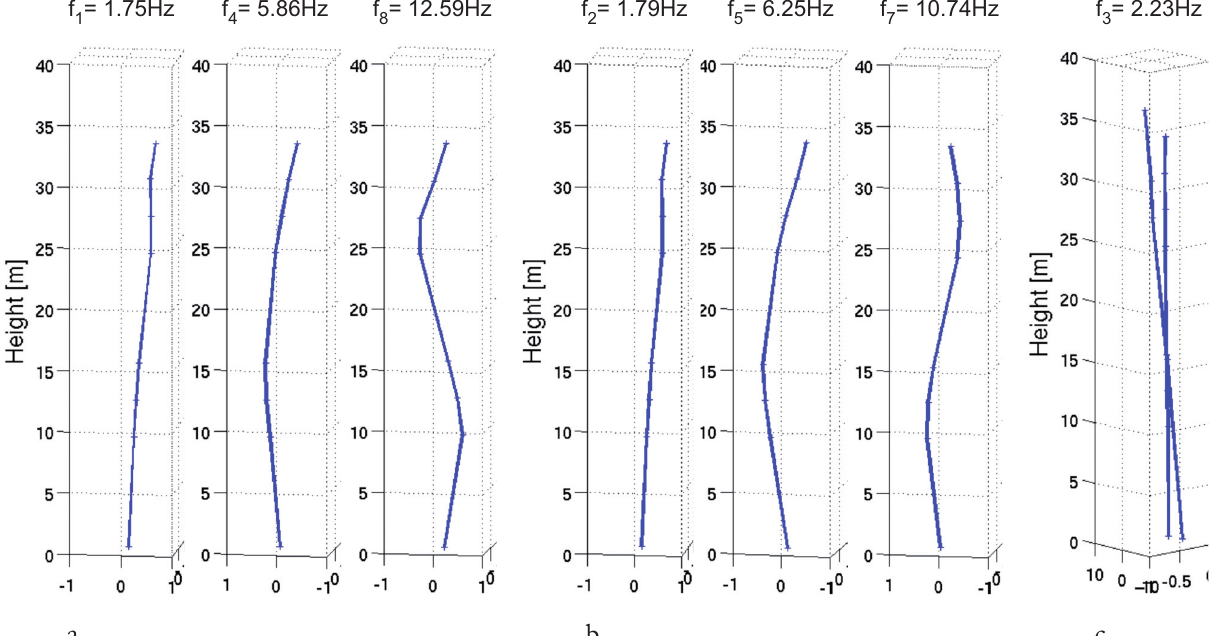
Figure 13. Eigenvectors corresponding to the first three bending modes for (a) the x and (b) y -direction. (c) First rotational